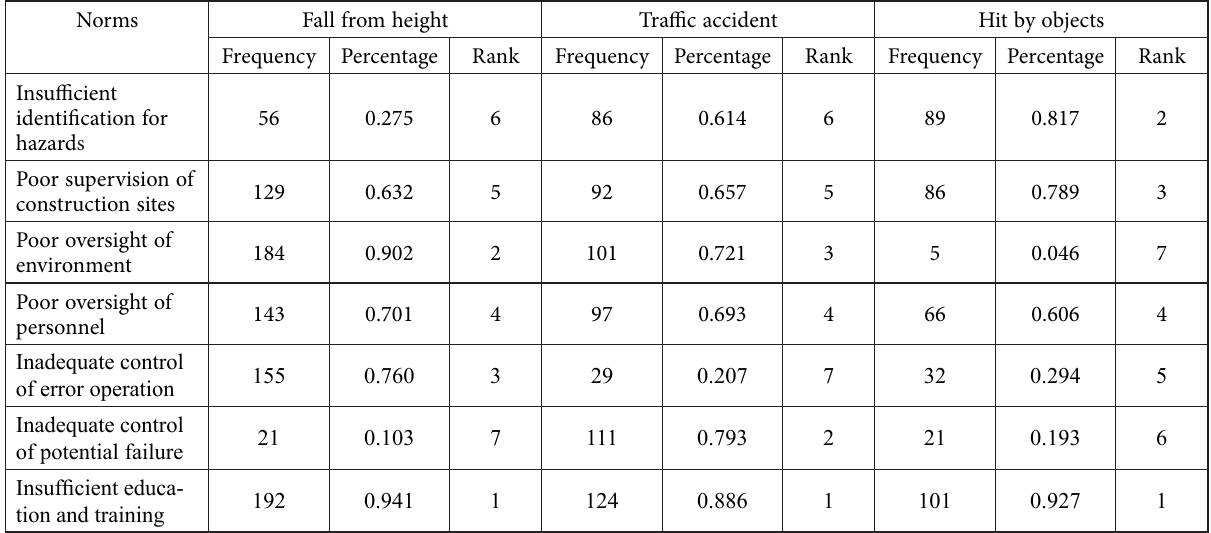
Table 9c. The norms of factor “inadequate supervision” (main norms)